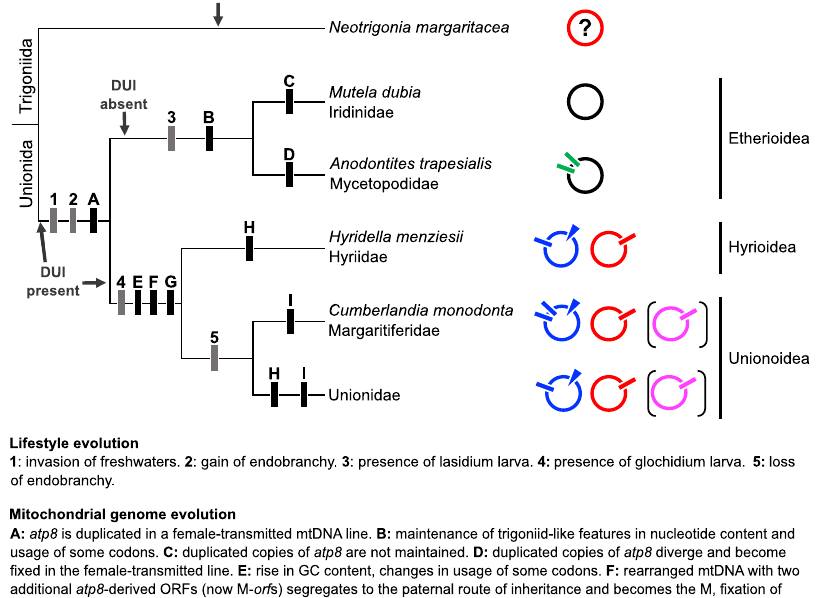
Figure 4. Model for the evolution of mt genomes and DUI in Palaeoheterodonta. The backbone tree represents the phylogeny obtainable by removing the M mtDNAs from the trees in Fig. 2. DUI presence/absence is specified for all major clades. At the tip of each final branch, the names of the species for which we obtained the mtDNA sequences in this study are indicated together with the respective family (no species are enlisted for Unionidae); superfamily affiliations are specified with bars on the right side of the figure. Circles beside a final branch represent a schematic mt genome structure with the following colour code: black, mtDNA of a non- DUI species; red, F mtDNA in a DUI species/family; blue, M mtDNA in a DUI species/family. Purple circles in parentheses represent the typical H mtDNA of secondarily hermaphroditic species in a given family. For N . margaritacea mt genome, the interrogation point highlights the uncertain presence of DUI in this species, while the red colour the fact that the genome we obtained, if DUI is present, would be its F. Bars on the mtDNAs represent atp8 -derived ORFs (green), M- orf s (blue), F- orf s (red), or H- orf s (purple), while blue triangles represent the elongated cox2 genes in M mtDNAs. The position of these latter features on the schematic mtDNAs reflects their actual location in the mt genomes (compare with Fig. 1). Bars inside the Unionida branches of the tree indicate evolutionary events and/or character states of lifestyle-related features as enlisted by ref. 14 (grey bars) or evolutionary events of mt genomes (black bars), described inside the